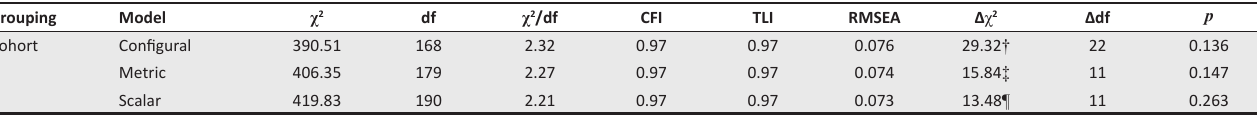
TABLE 4: Measurement invariance fit statistics. Grouping